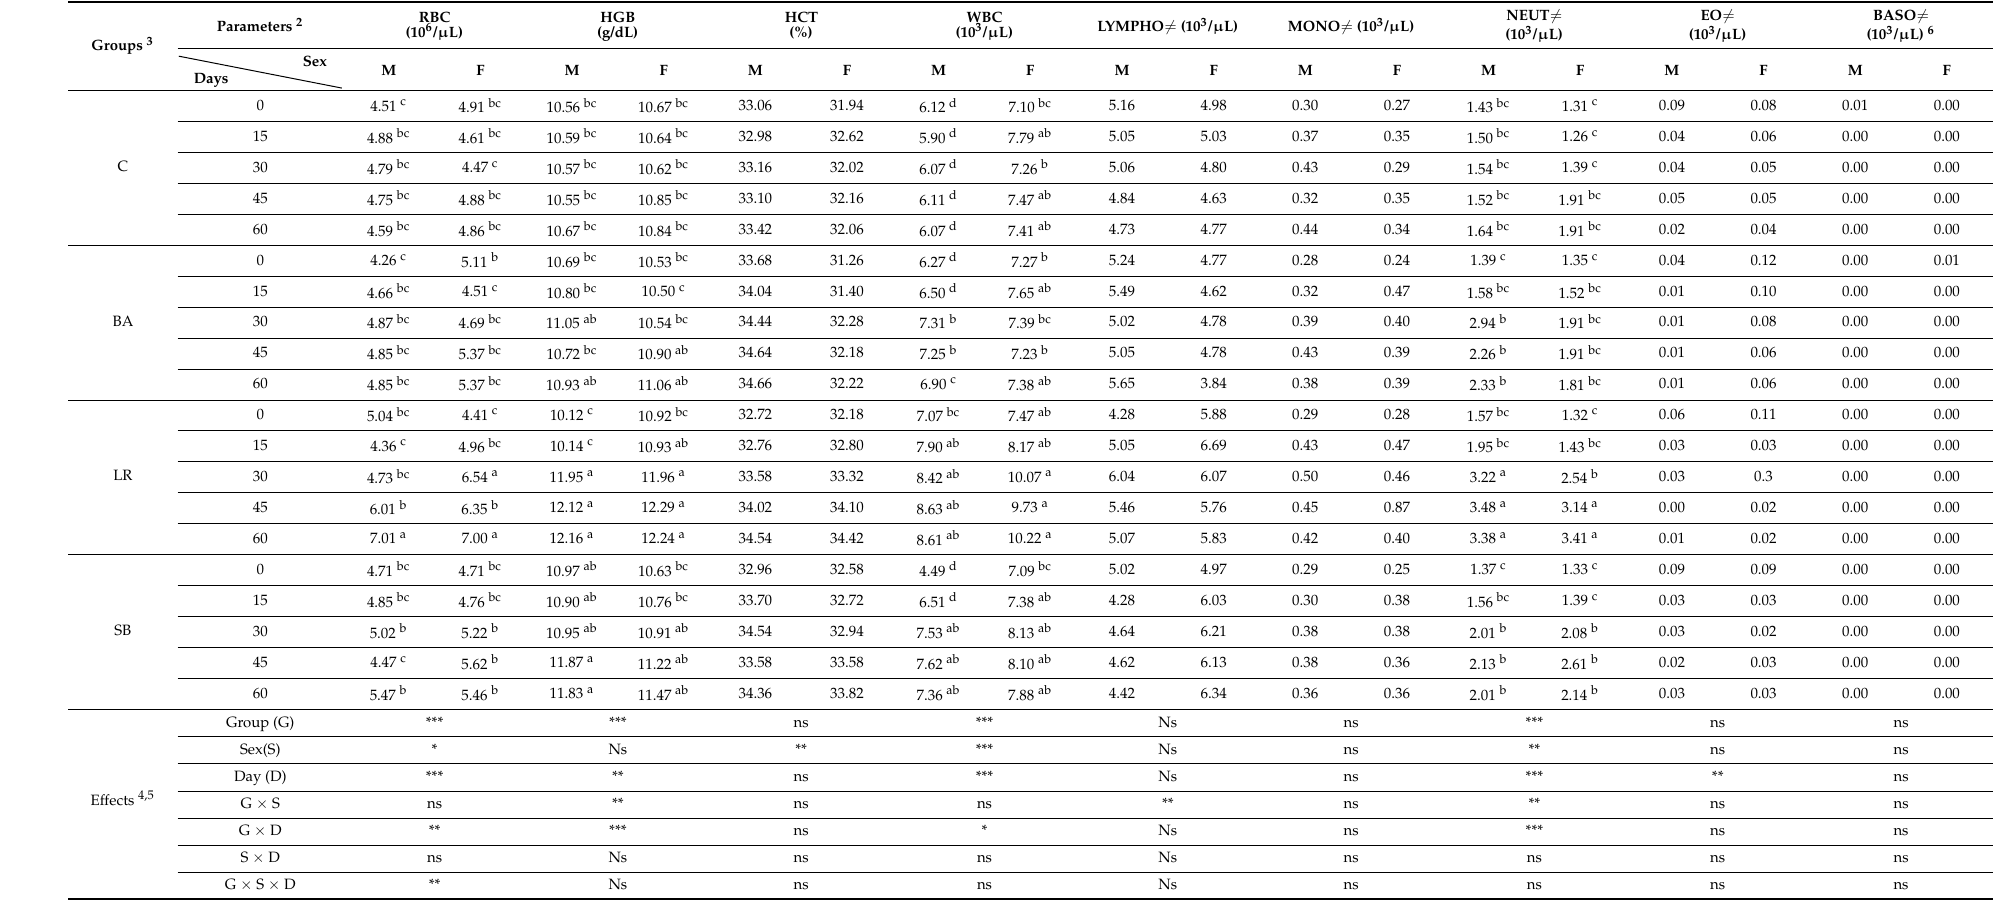
Table 3. Effects of dietary supplementation with probiotics on haematological parameters of healthy rabbits 1